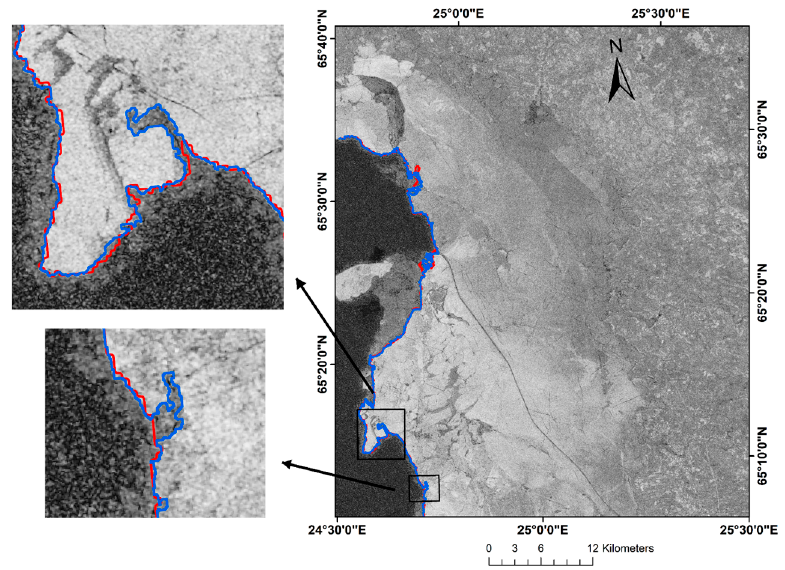
Figure 9. The comparison between two methods in the same image. The blue curve represents the result from the method proposed in this paper, and the red curve represents the result from the reference method.